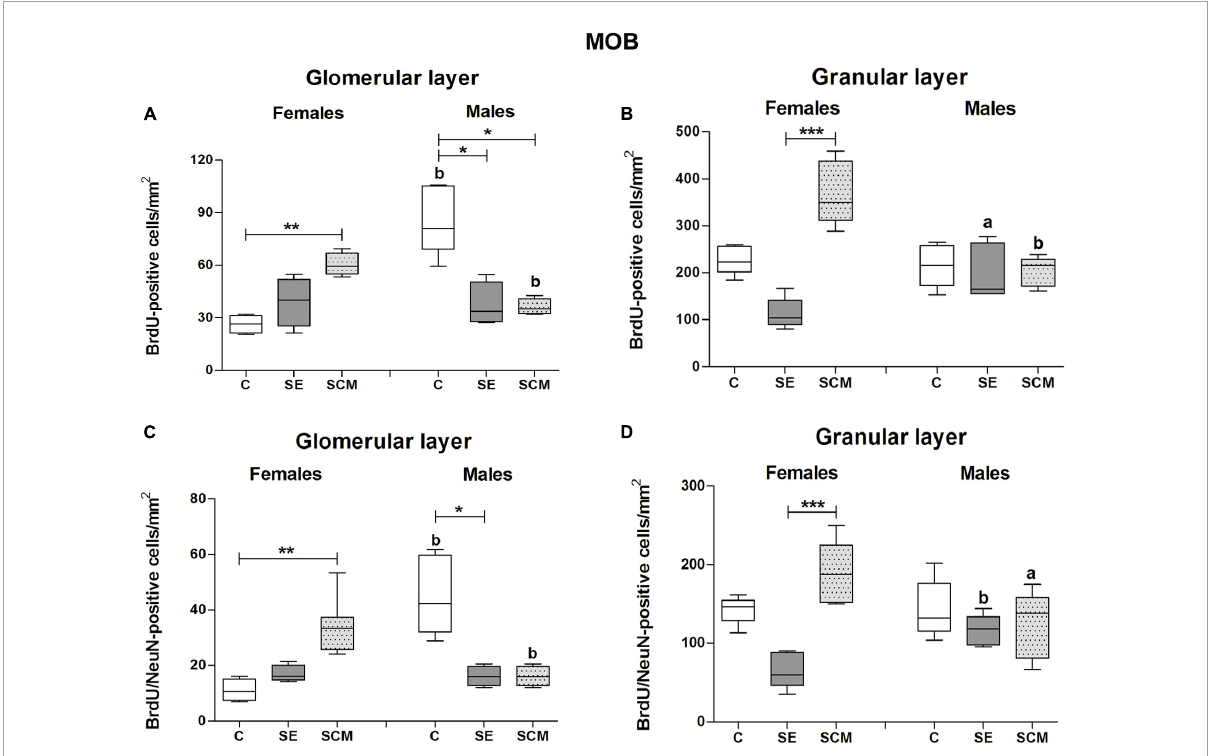
FIGURE4 Number of BrdU and BrdU/NeuN-positive cells in the glomerular and granular cell layers of the main olfactory bulb (MOB) in control (C), Social exposure (SE), and Social cohabitation with mating (SCM) groups Kruskal-Wallis followed by Dunn’s post-hoc tests; * p < 0.05; ** p < 0.01 and *** p < 0.001, were considered significant. Differences between female and male prairie voles were analyzed using the Mann-Whitney U test. a p < 0.05, and b p < 0.01. Animals were excluded from the analysis if three well-preserved sections were not obtained. Female subjects; C = 4, SE = 4, SCM = 7. Male subjects; C = 7, SE = 5, SCM = 5. a mean different from the opposite sex p < 0.05. b mean different from the opposite sex p < 0.01.